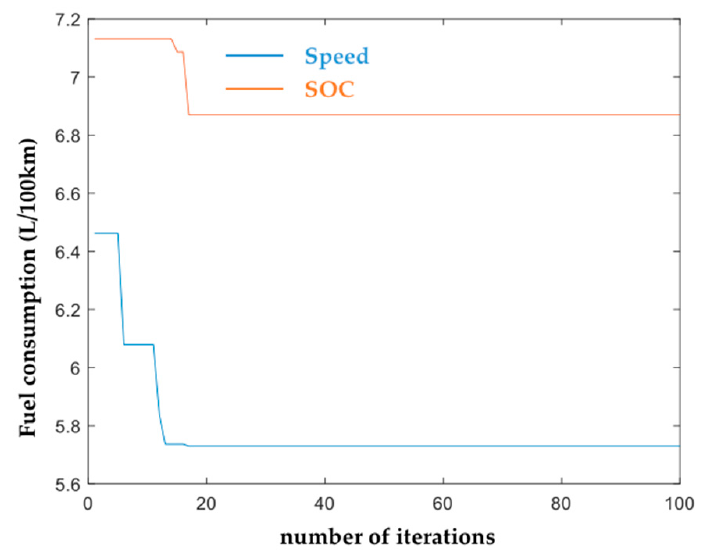
Figure 10. The iterative curve of the PSO algorithm.